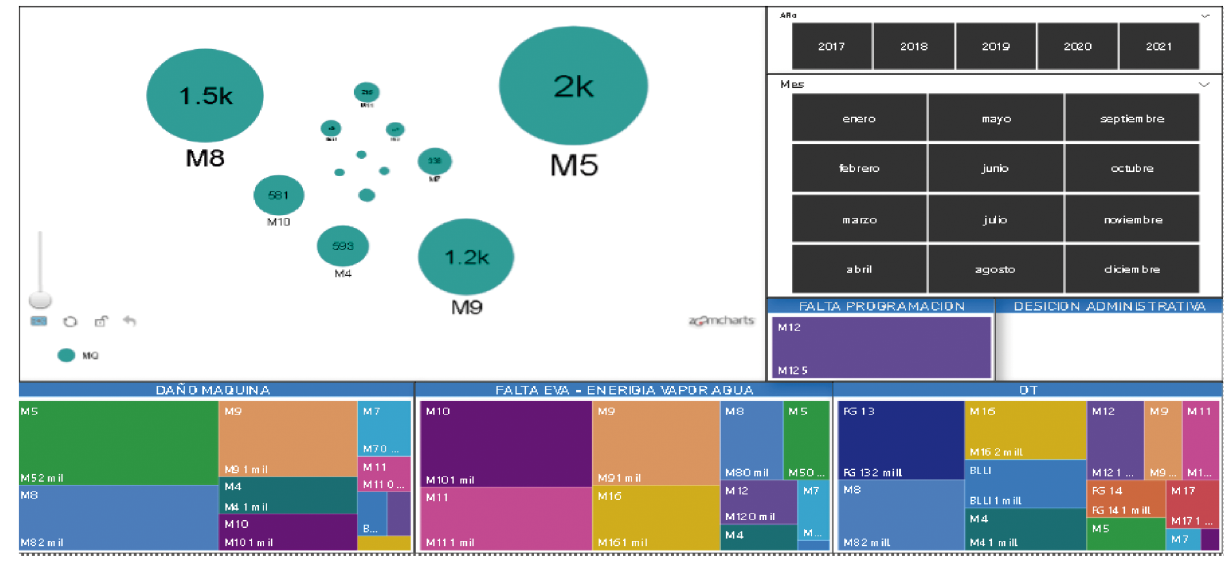
Figure 12. Indirect Operational and non-operational